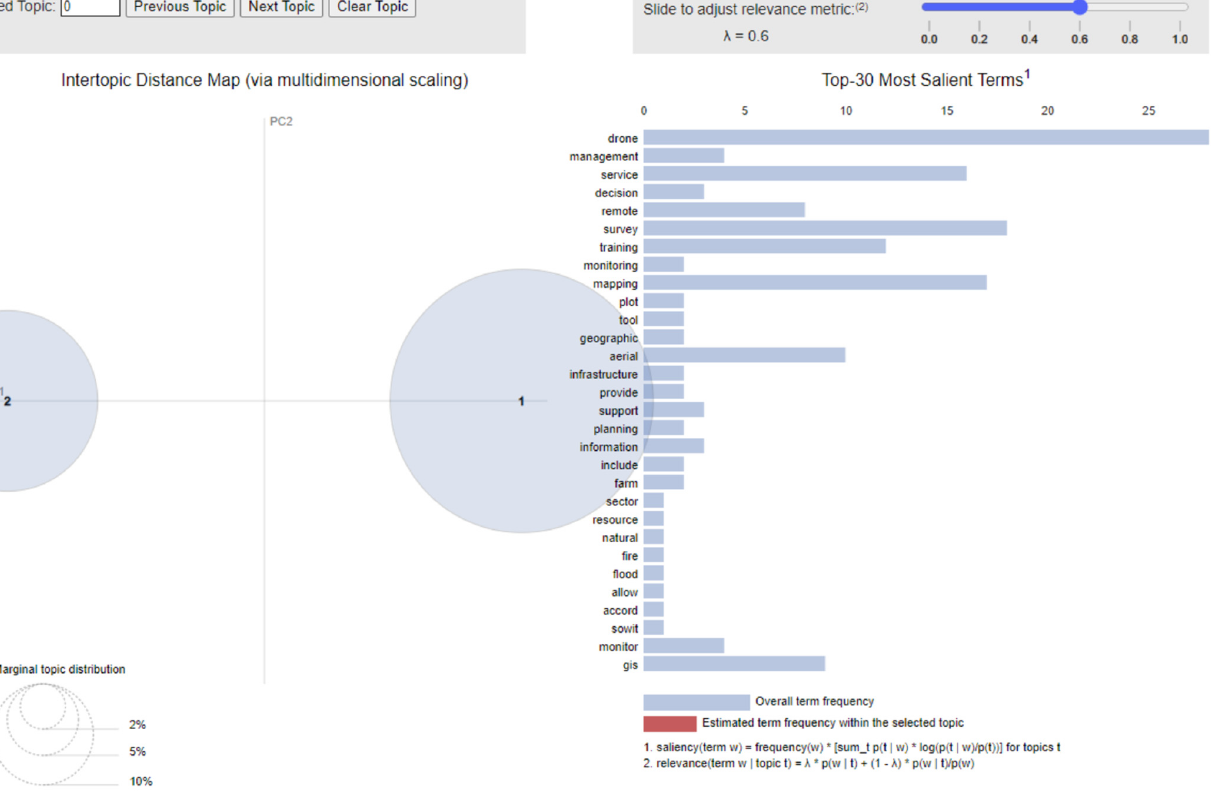
Figure 2. LADvis representation of the topics and term bar charts. For the salient terms see Chuang et al. (2012) and for the relevant terms see Sievert & Shirley (2014). Chuang et al. (2012) and for the relevant terms see Sievert & Shirley